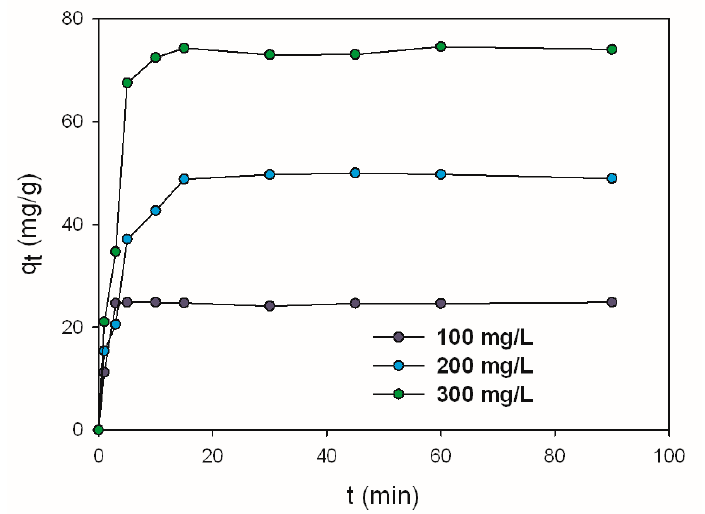
Figure 2. Effect of contact time and initial sodium copper chlorophyllin (SCC) concentration on the adsorption capacity of H. communis marine sponge skeleton (0.1 M NaCl).